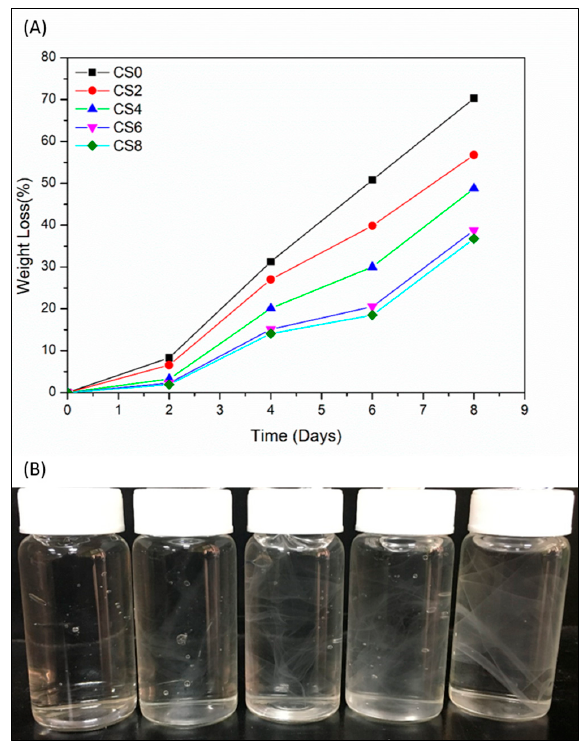
Figure 8. ( A ) Biodegradability and ( B ) stability of CS0, CS2, CS4, CS6, and CS8 films.